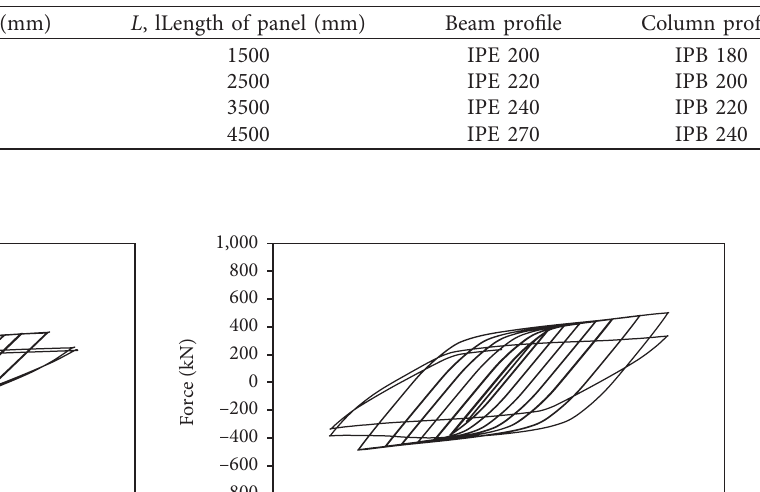
Table 5: Panel aspect ratios.